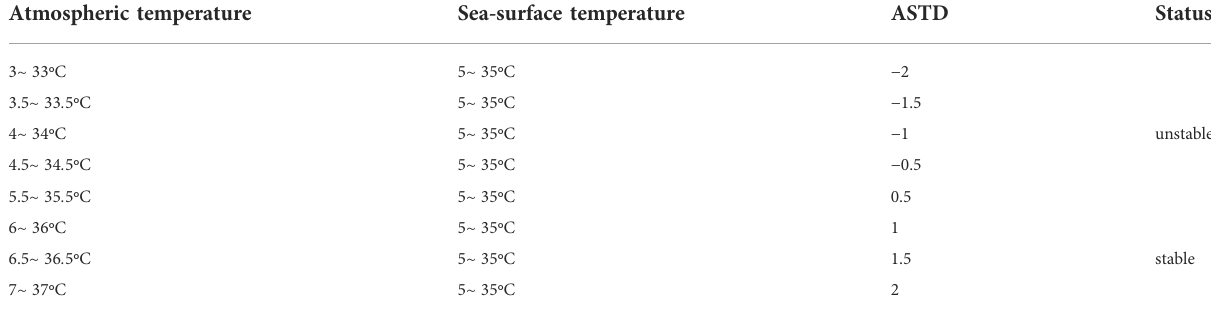
TABLE 1 Setting of sea-surface temperature and atmospheric temperature